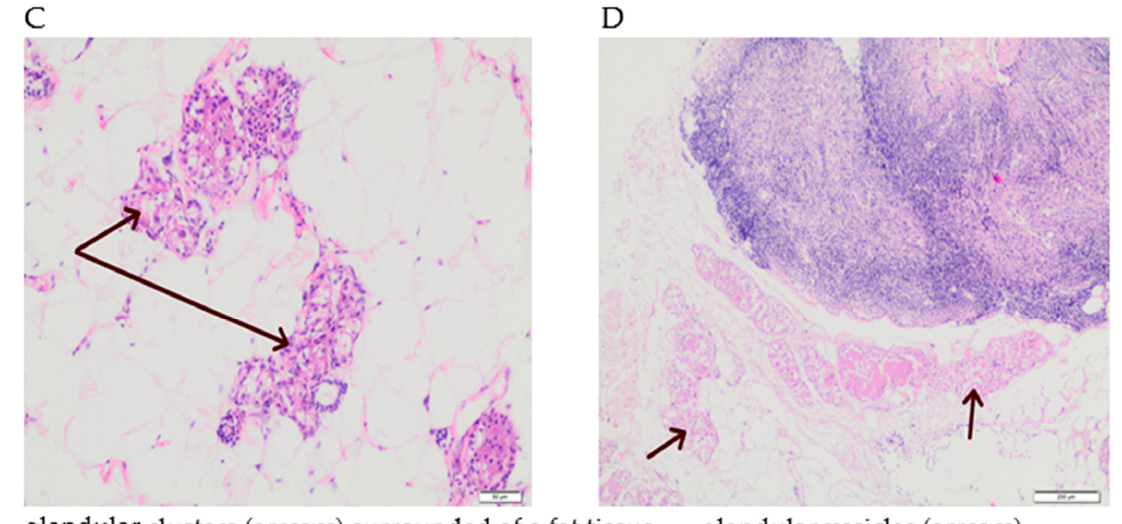
Figure 8. Hematoxylin-eosin-stained sections of anterior prostate from rats implanted LNCaP cells. ( A )—rats fed standard diet—without supplementation; ( B )—rats fed diet supplemented with iron; ( C )—rats fed diet supplemented with calcium; ( D )—rats fed diet supplemented with zinc.